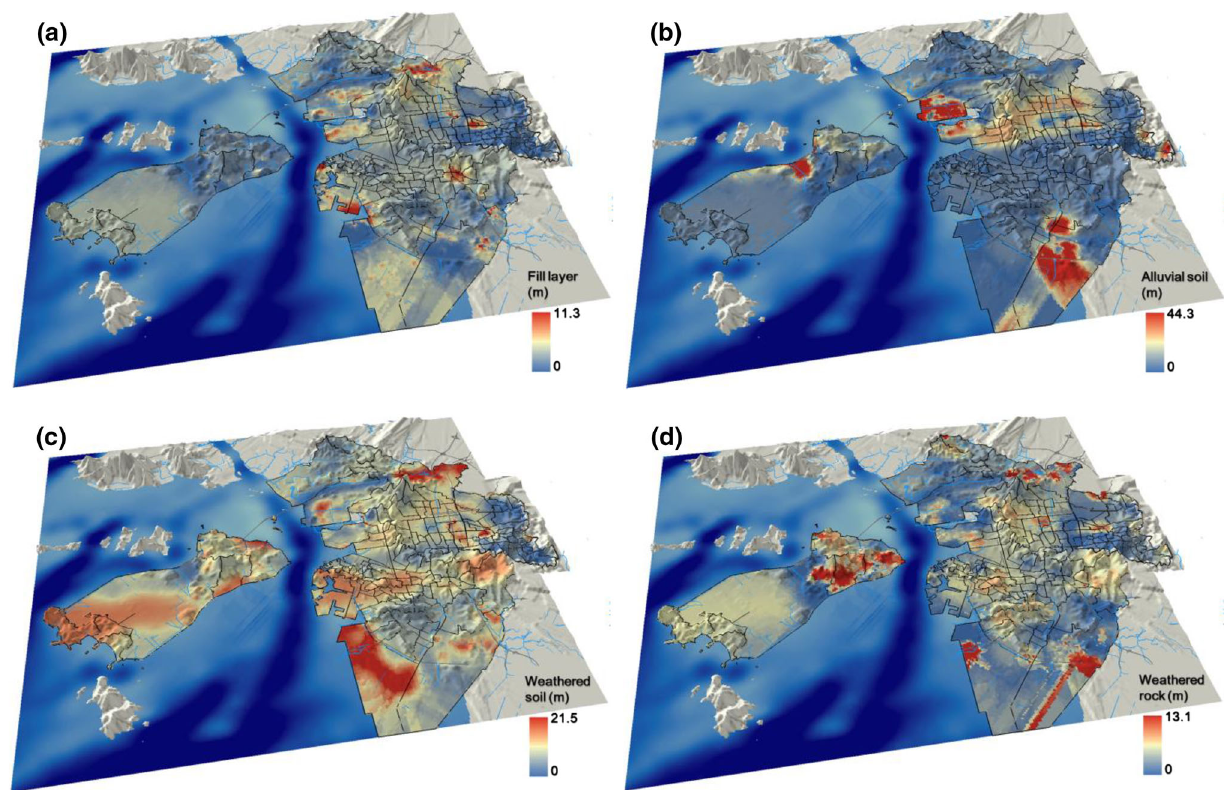
Fig. 7 The Incheon and Bucheon study areas in South Korea: Geotechnical spatial grid information of geo-layer thickness in the Incheon and Bucheon areas: a fill; b alluvial soil; c weathered soil; d weathered